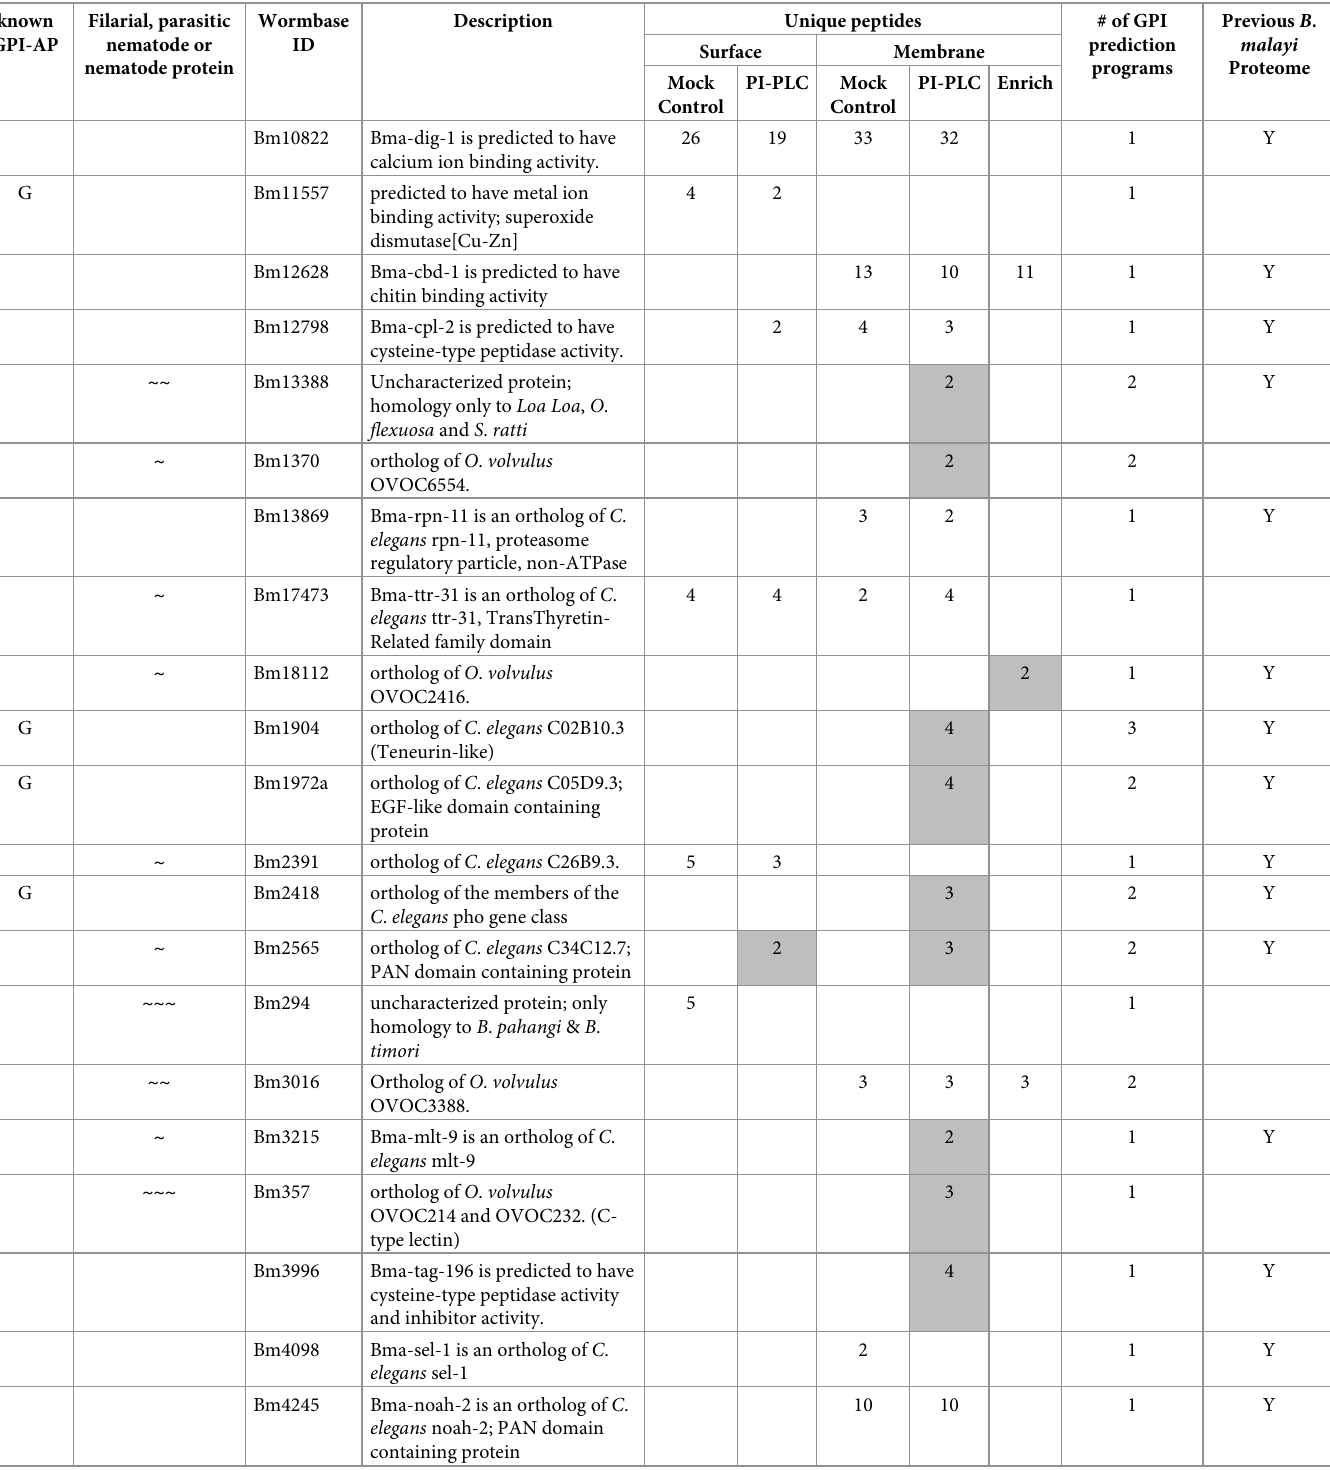
Table 2. Correlation of computational and experimental identification of candidate B . malayi